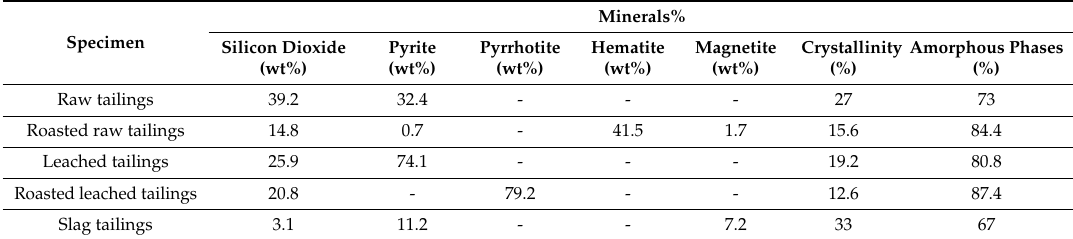
Table 3. The obtained results from Rietveld analysis.